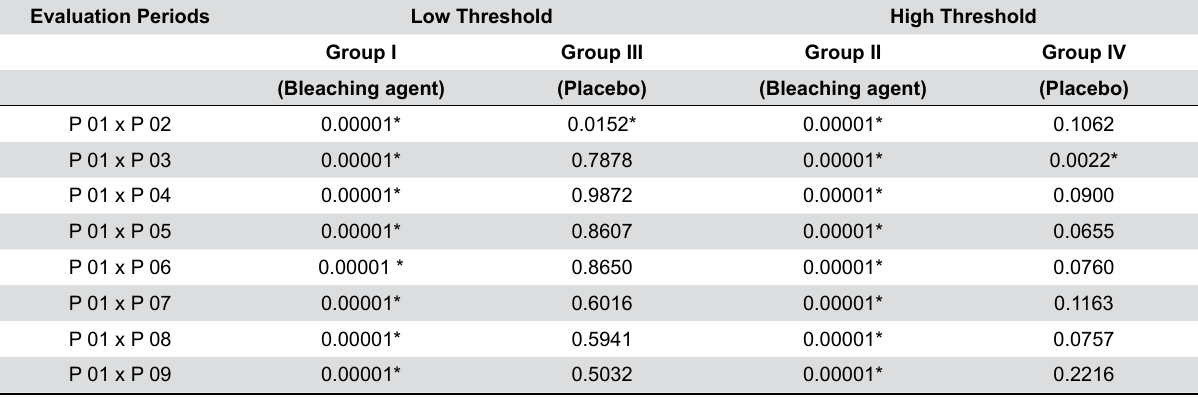
Table 3- P-values obtained after dental cold sensation evaluation in different periods